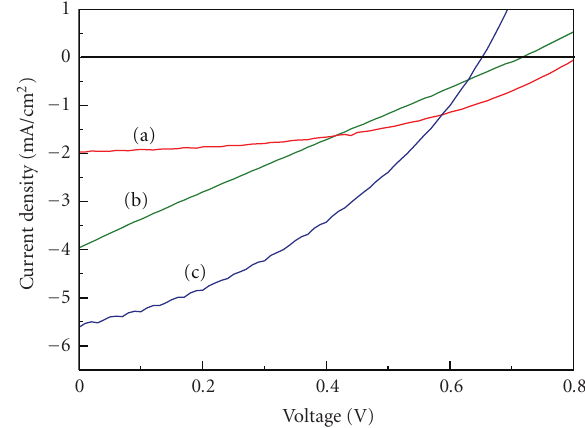
Figure 6: I-V characteristics of ZnO nanorod DSSCs. Curve (a): CVD-grown sample, curve (b): CBD-grown sample, and curve (c): conventional